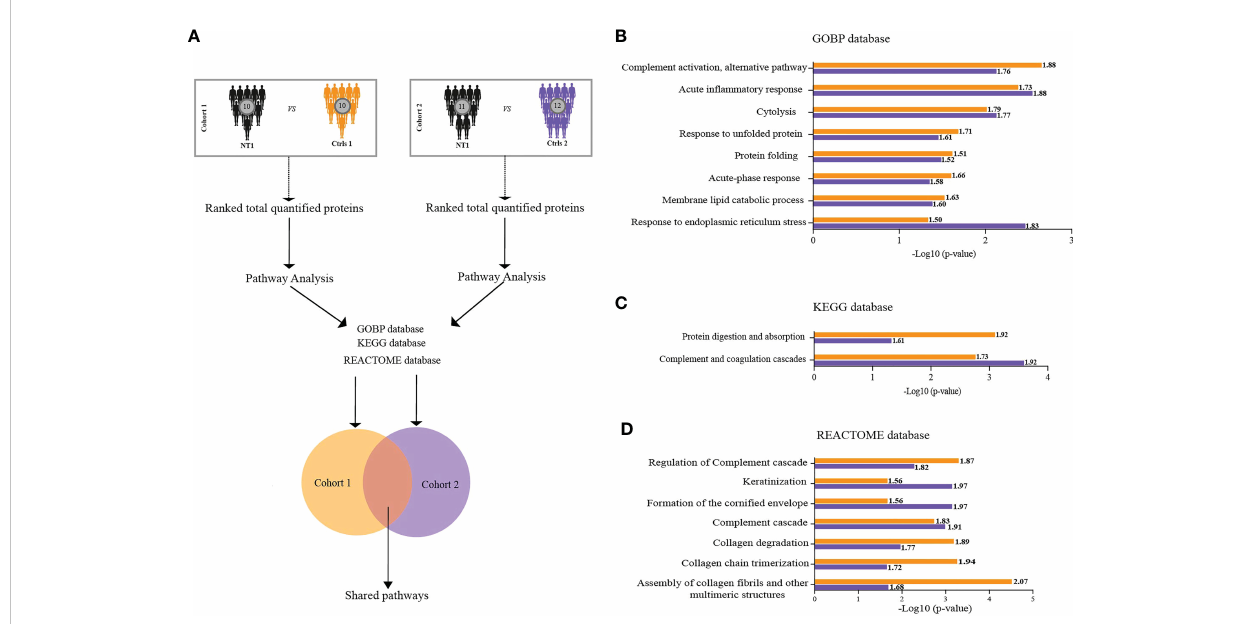
FIGURE 3 Biological pathways enriched in the CSF of NT1 patients in both cohort 1 and cohort 2. (A) Scheme of the analytical design: In each cohort separately, total proteins were ranked based on their fold change then pathway analysis was performed using the GSEA feature of Cluster Pro fi ler. Three databases were interrogated (GOBP, KEGG and REACTOME). Only the statistically signi fi cant pathways shared between the two cohorts were considered for further analysis. (B – D) Log10 p-values of pathway enrichment in cohort 1 (Orange) and cohort 2 (Purple), in reference to the three databases. Values close to each bar represent the normalized enrichment score (NES), predicting activation or inhibition of a given